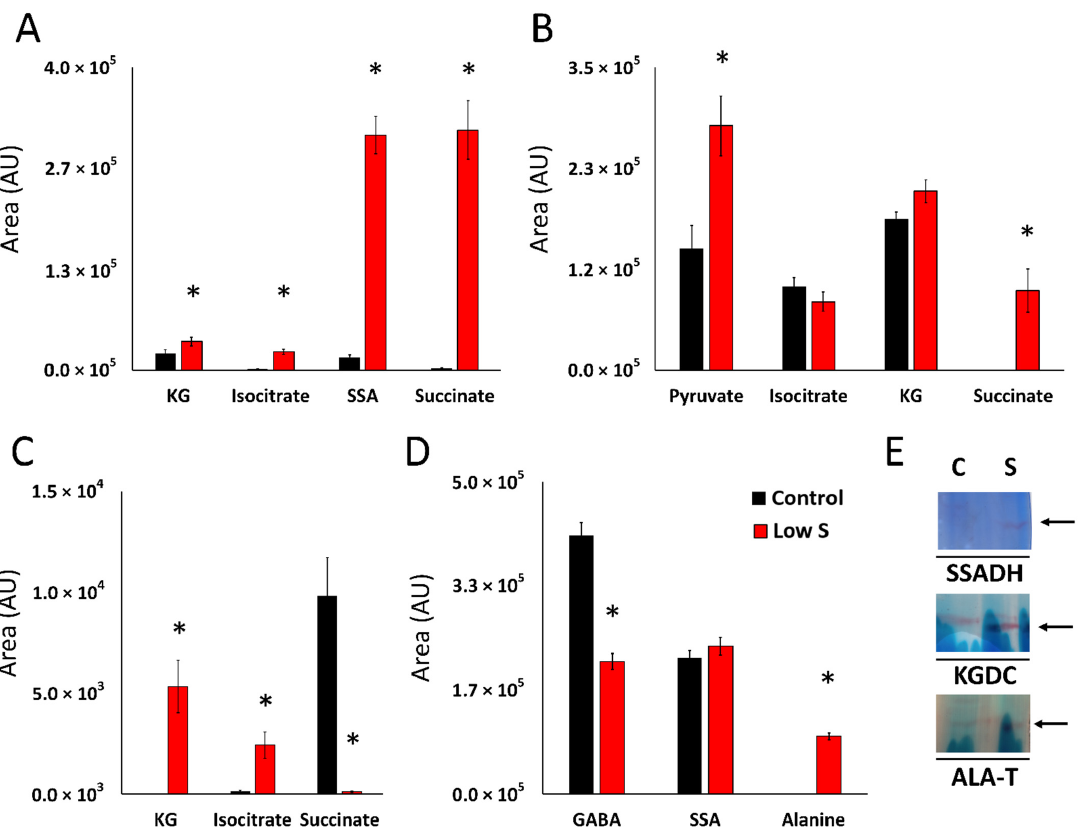
Figure 3. Multiple routes to α -ketoglutarate in P. fluorescens subject to sulfur starvation. ( A ). Quantification of metabolites in membrane cell free extracts of P. fluorescens grown in control and limited-sulfur (Low S) conditions incubated with 5 mM glutamine for 60 min. Glutamine utilization leads to enrichment of KG, Isocitrate, SSA and succinate. ( B ). Quantification of metabolites in cell free extracts of P. fluorescens grown in control (black) and sulfur-limited (red) conditions incubated with 5 mM isocitrate for 60 min. Isocitrate metabolism leads to enrichment of KG, succinate and pyruvate. ( C ). Quantification of metabolites in cell free extracts of P. fluorescens grown in control and sulfur-limited (Low S) conditions incubated with 5 mM succinate, 10 mM HCO 3- for 60 min. Succinate metabolism results in the production of isocitrate and KG. ( D ). Quantification of metabolites in membrane cell free extracts of P. fluorescens grown in control and sulfur-deficient (Low S) conditions incubated with 5 mM GABA, 5 mM pyruvate for 60 min. Production of alanine, a by-product of GABAT is identified. ( E ). Activity analysis by BN-PAGE of succinate semialdehyde dehydrogenase (SSADH), α -ketoglutarate decarboxylase (KGDC) and alanine transaminase (ALA-T). SSADH, KGDC and ALA-T. c = control, s = low sulfur. Data are represented as means ± standard deviation. n = 3, * = p < 0.05.